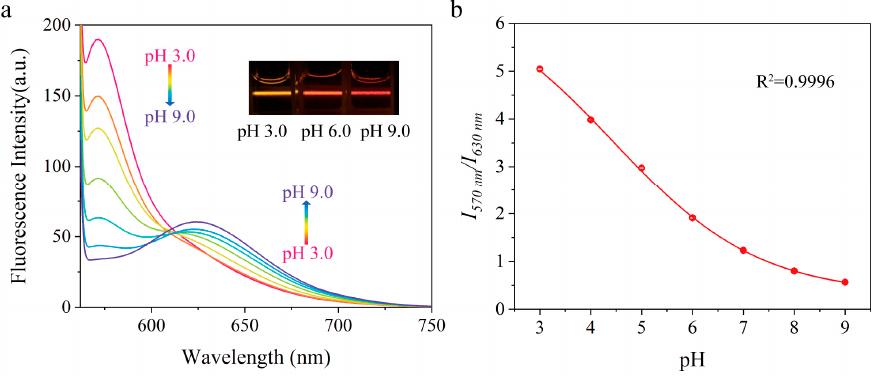
Figure 5. ( a ) The fluorescence emission spectra of the nanosensors in BR buffer solution at different pH values. the insert: photograph of nanosensors in BR buffer solution at different pHs under 532 nm laser pointer. ( b ) pH − dependent emission intensity ratio of the nanosensors at 570 nm and 630 nm.